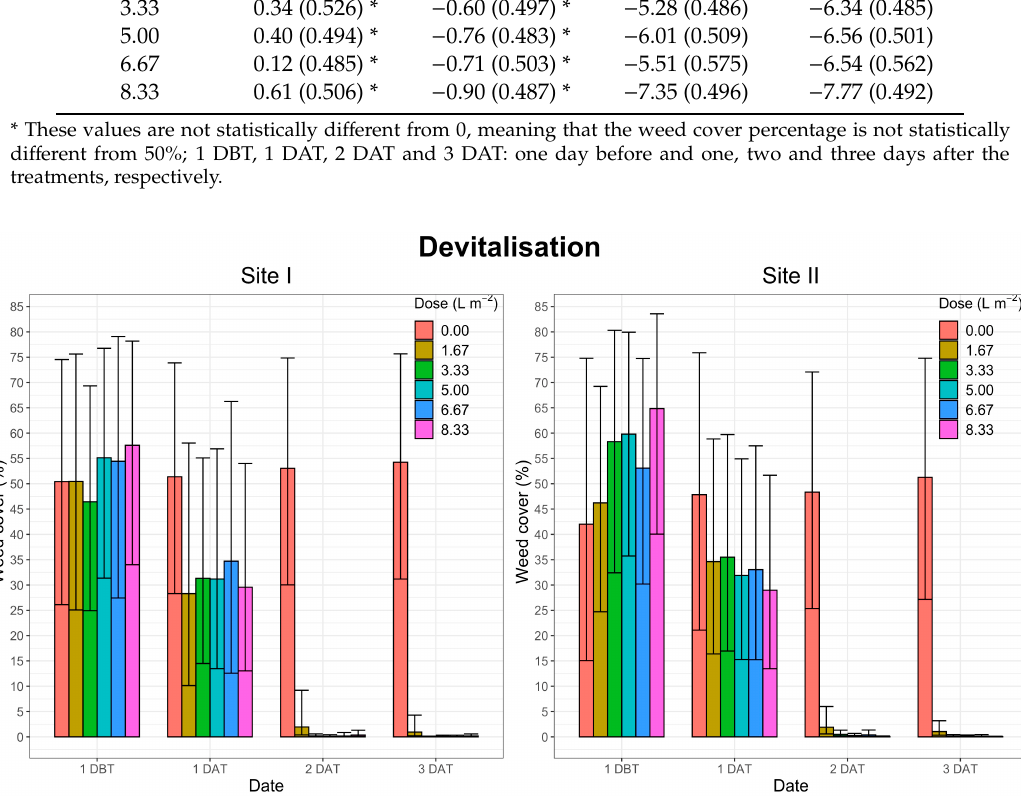
Figure 3. Devitalisation (i.e., from hot foam application to death of weeds) bar graph of back means (Table 3) and the 95% confidence interval of weed cover percentage as a ff ected by the foam dose (0, 1.67, 3.33, 5.00, 6.67, 8.33 L m − 2 ), the site and the evaluation date in the Festuca arundinacea